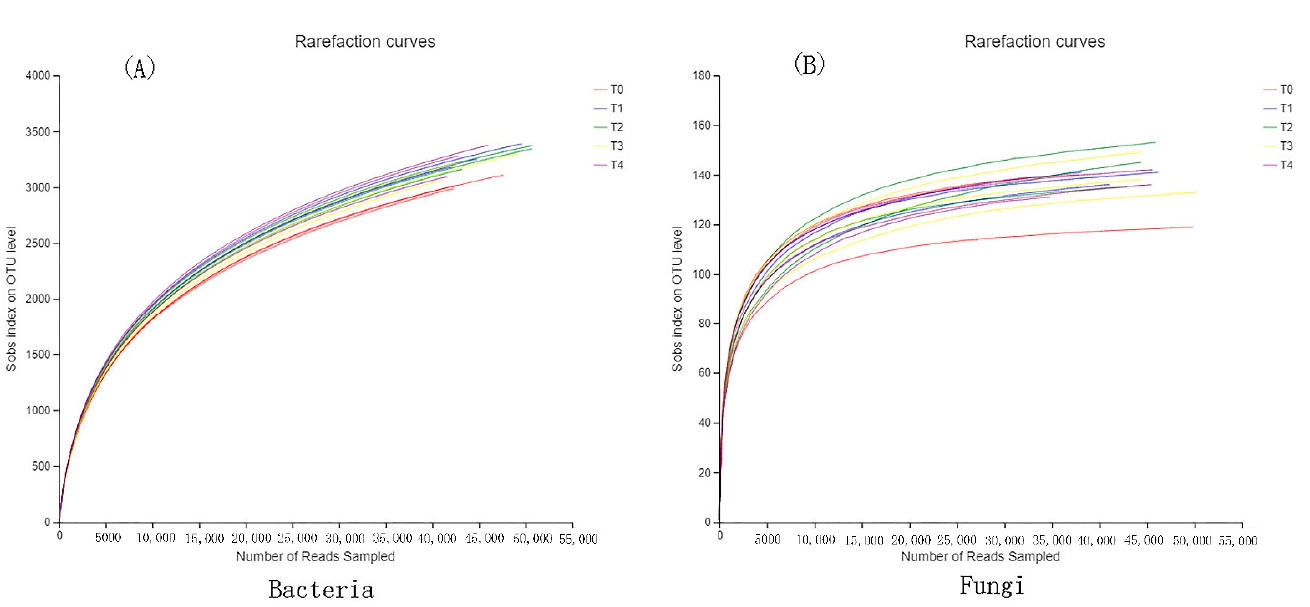
Figure 1. Dilution curve analysis of each processed sample (OTU level). Table 3. Analysis of diversity indices among different treatments. The data are means ± standard deviation. Different lowercase letters in the same row indicate significant differences between treatments ( p <